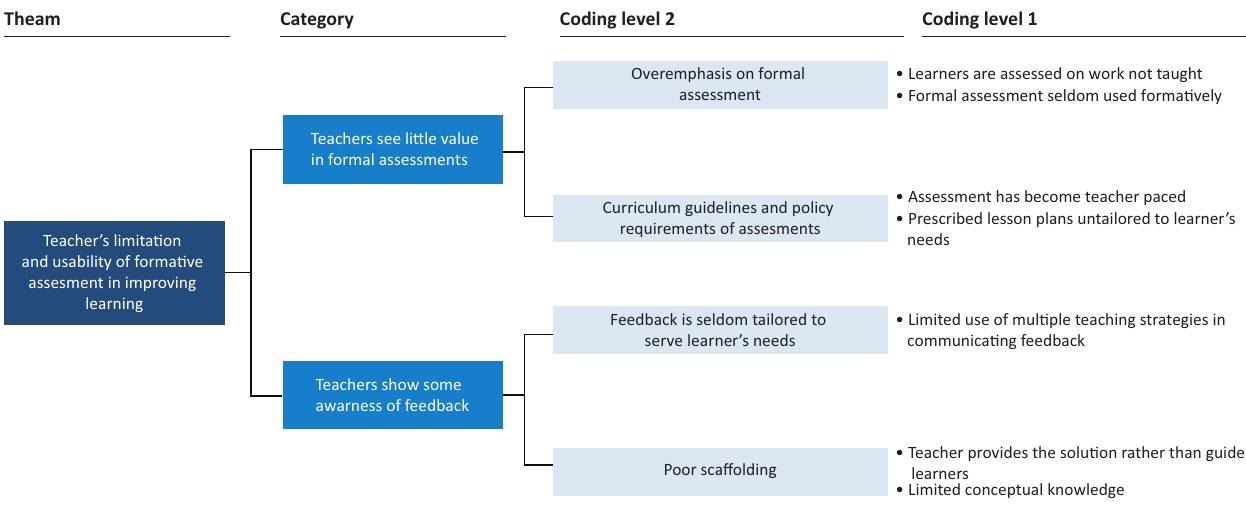
Figure 1. I used this strategy to strengthen the reliability of my data analysis.